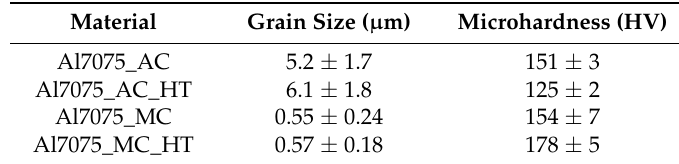
Table 4. The grain size determined from EBSD images and microhardness values after annealing 425 ◦ C/1